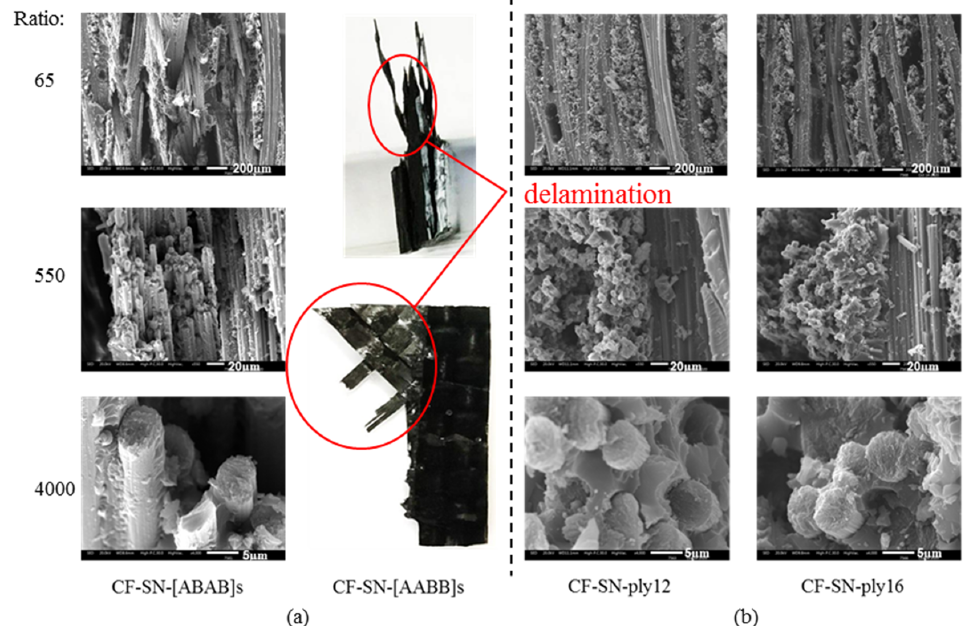
Figure 15. SEM images of the fracture position of the specimen group ( a ) with different lay-up sequences and ( b ) with different layer numbers. The specimen containing 45° fiber orientation was pulled out and the lay-up was delaminated severely, and small pieces of broken fiber can be seen in thicker specimens.